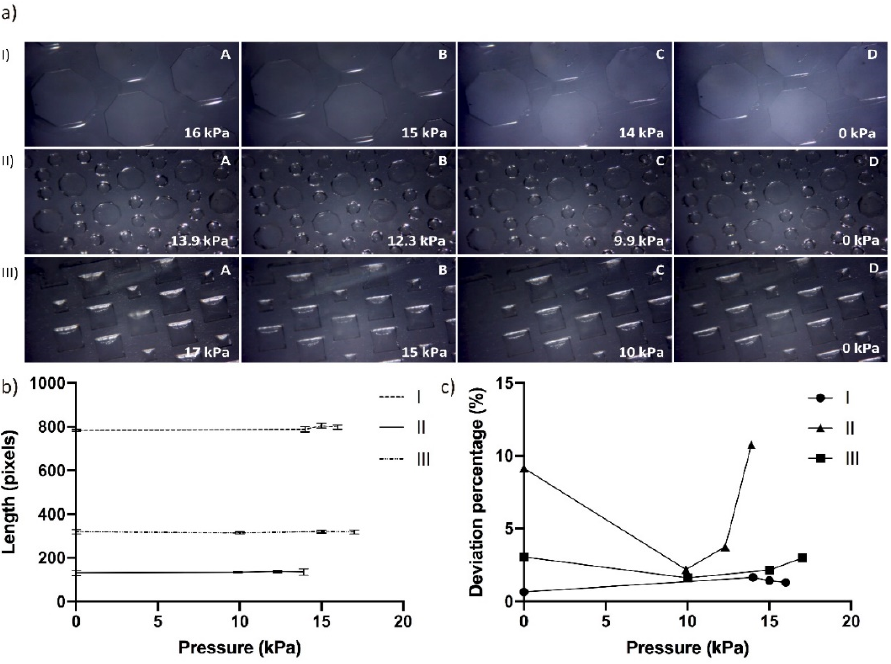
Figure 5. ( a ) Images of different PDMS microfluidic devices ( aI – aIII) by applying different pressures. Changes in the morphology and the structure size were analyzed under high ( A ), intermediate ( B ), low ( C ), and no pressure ( D ). Four measurements at each pressure were obtained for each image. ( b ) Structure lengths (pixels) of different microfluidic devices (I, II, and III) measured according to the applied pressure (kPa) Error bars represent standard deviation between measurements. ( c ) Variation of deviation percentage in length measurements for each applied pressure.